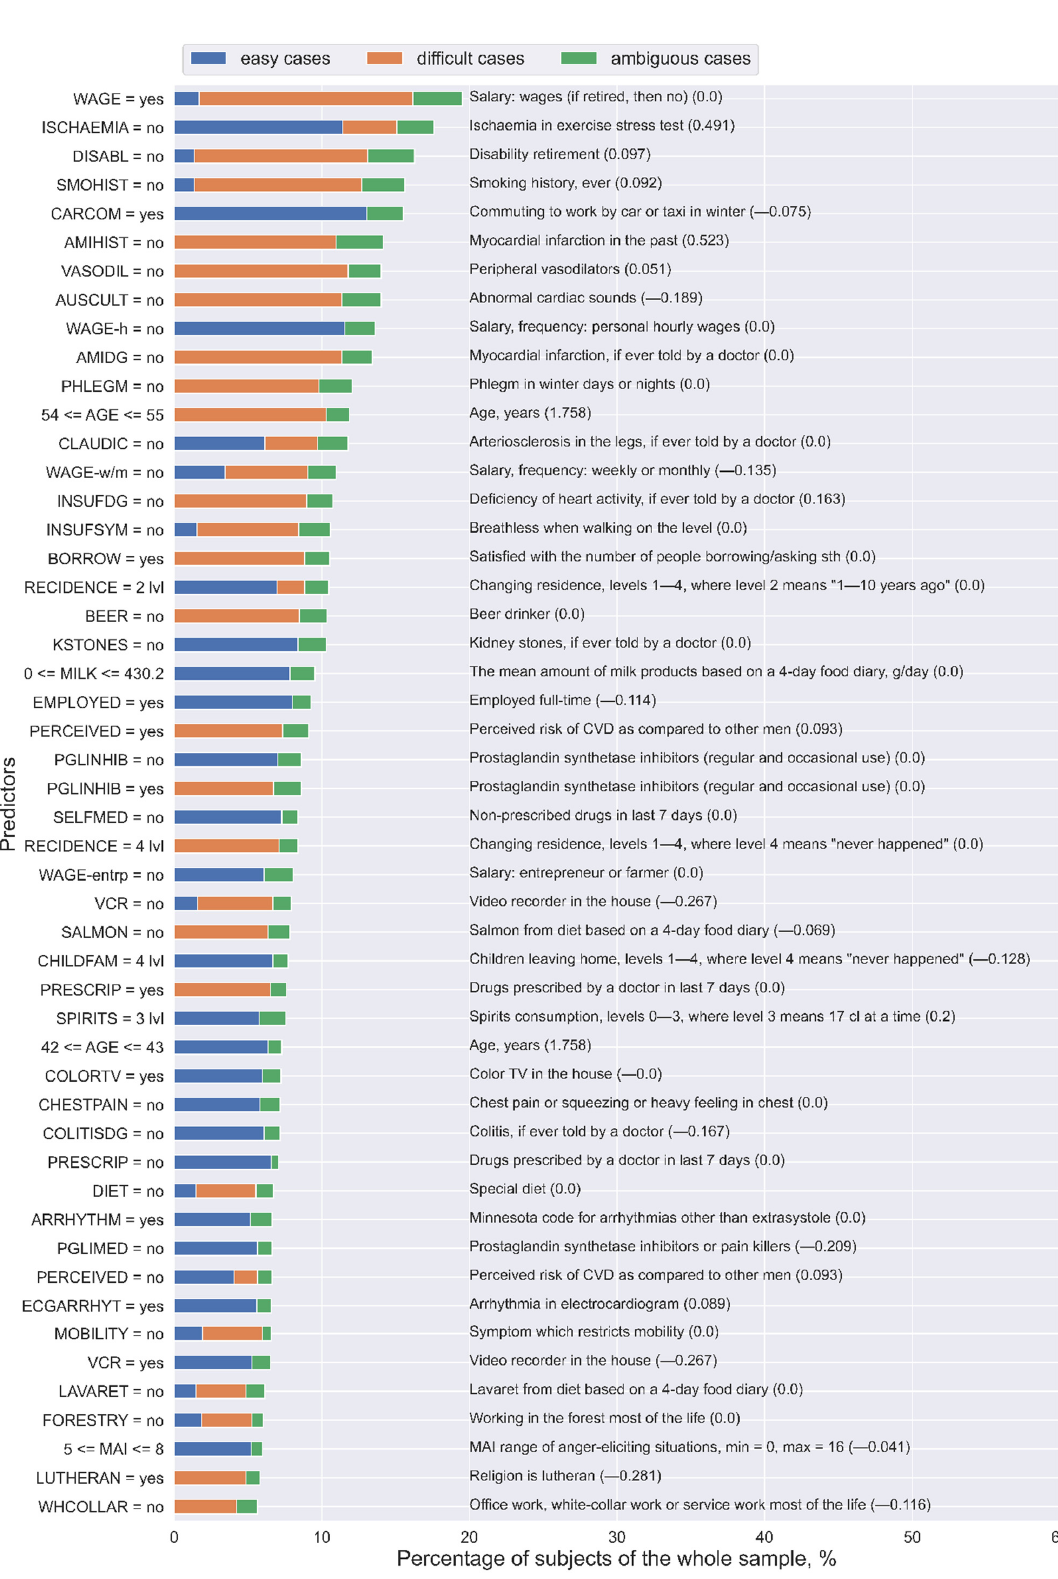
Figure 5. The 50 most important predictors and their values extracted from the final set of rules for the Lasso logistic regression (LLR) model using the KIHD sample. The numbers in parentheses are the weight coefficients in the LLR model for the corresponding predictors: Some of these variables were not selected as important for LLR, but they were important for analyzing “easy” and “difficult”